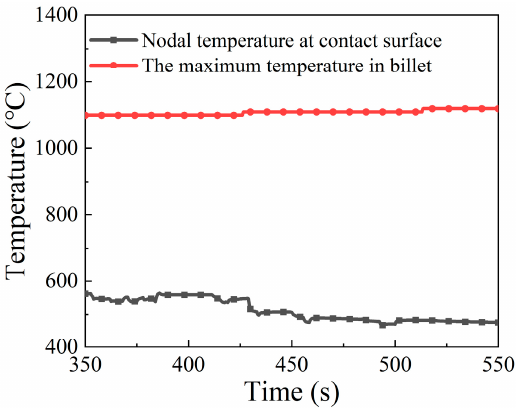
Figure 15. Evolution of the maximum temperature and the nodal temperature of contact surface over time during the intermediate stage of the forming process.